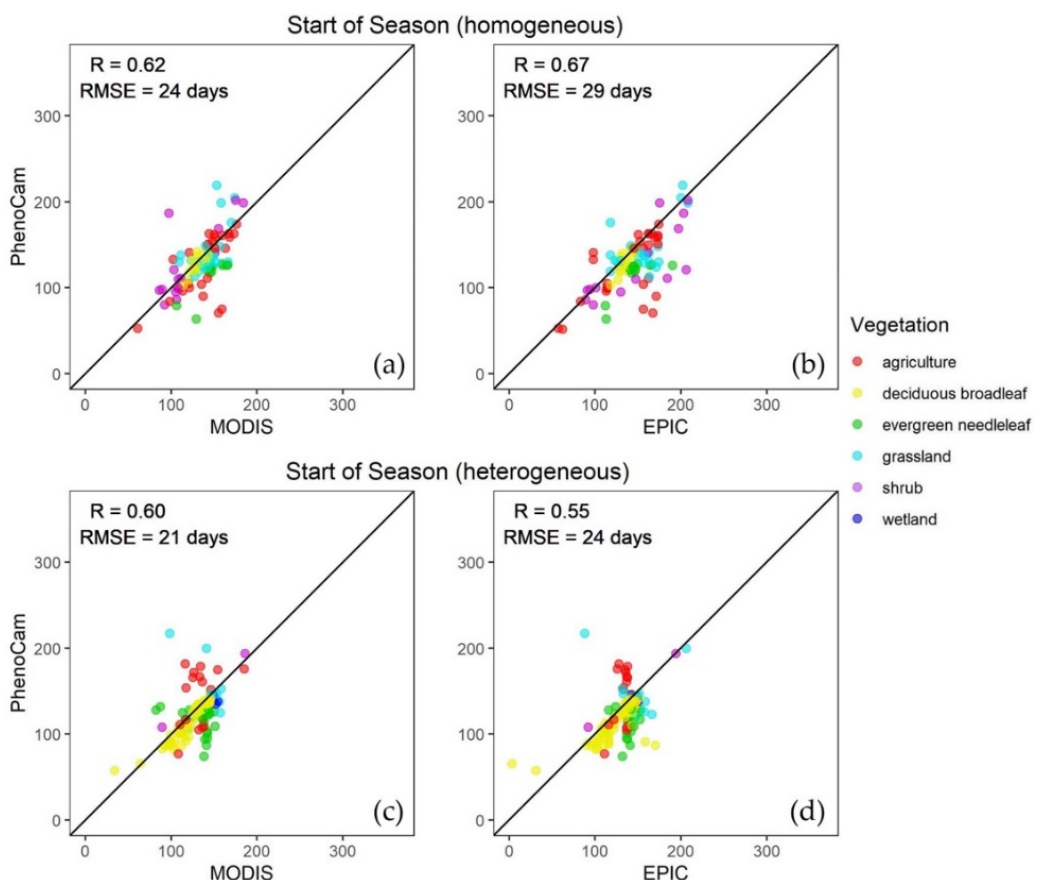
Figure 12. The correlation of SOS (in days) for PhenoCam and ( a ) MODIS and ( b ) EPIC for homogeneous sites only, and PhenoCam and ( c ) MODIS and ( d ) EPIC for heterogeneous sites only during 2016–2018.